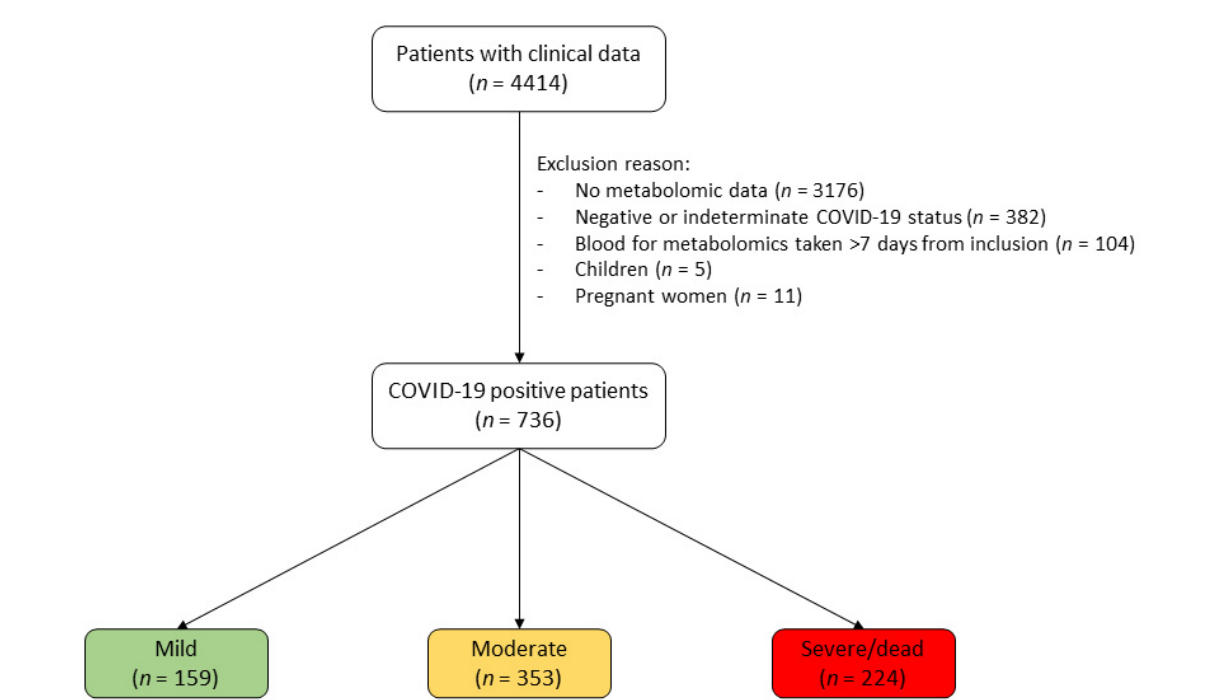
Figure 1. Patient-selection flowchart. PCR tests were used to assess COVID-19 status. Symptom severity was established at inclusion, using the World Health Organization (WHO) criteria [22] .